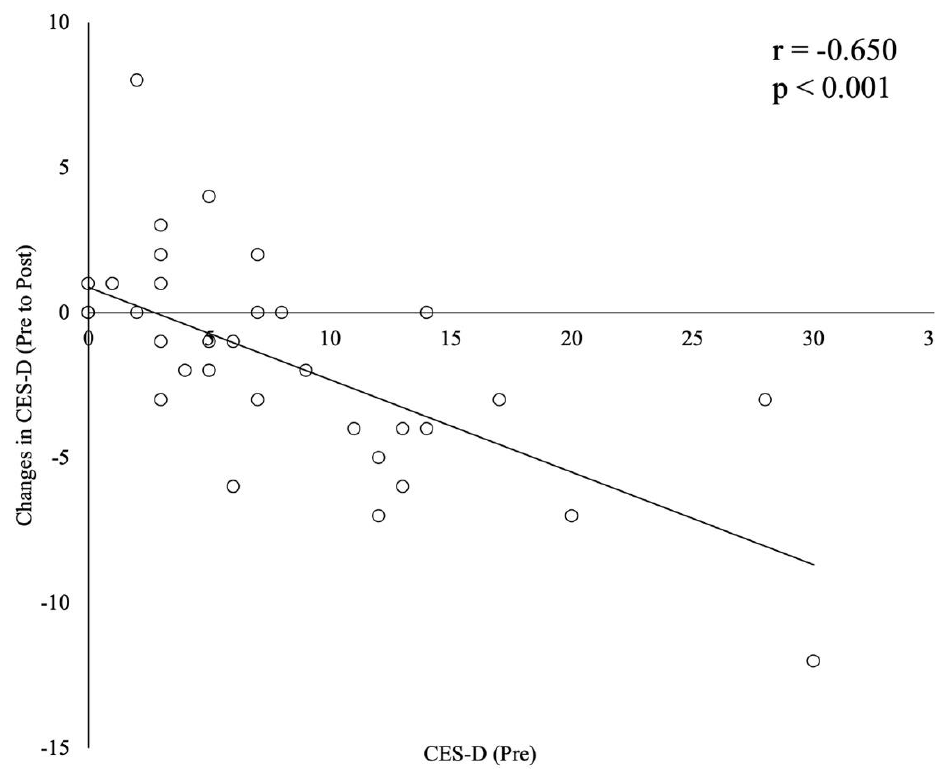
Figure 1. A correlation between baseline and changes in CES-D after eight weeks of online low load resistance training in Study 2.